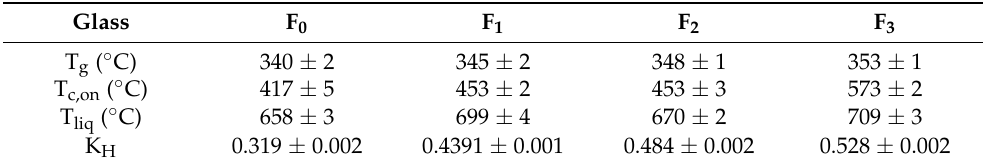
Table 2. Glass transition (T g ) crystallization (T c,on ) melting (T liq ) temperatures and K H of prepared